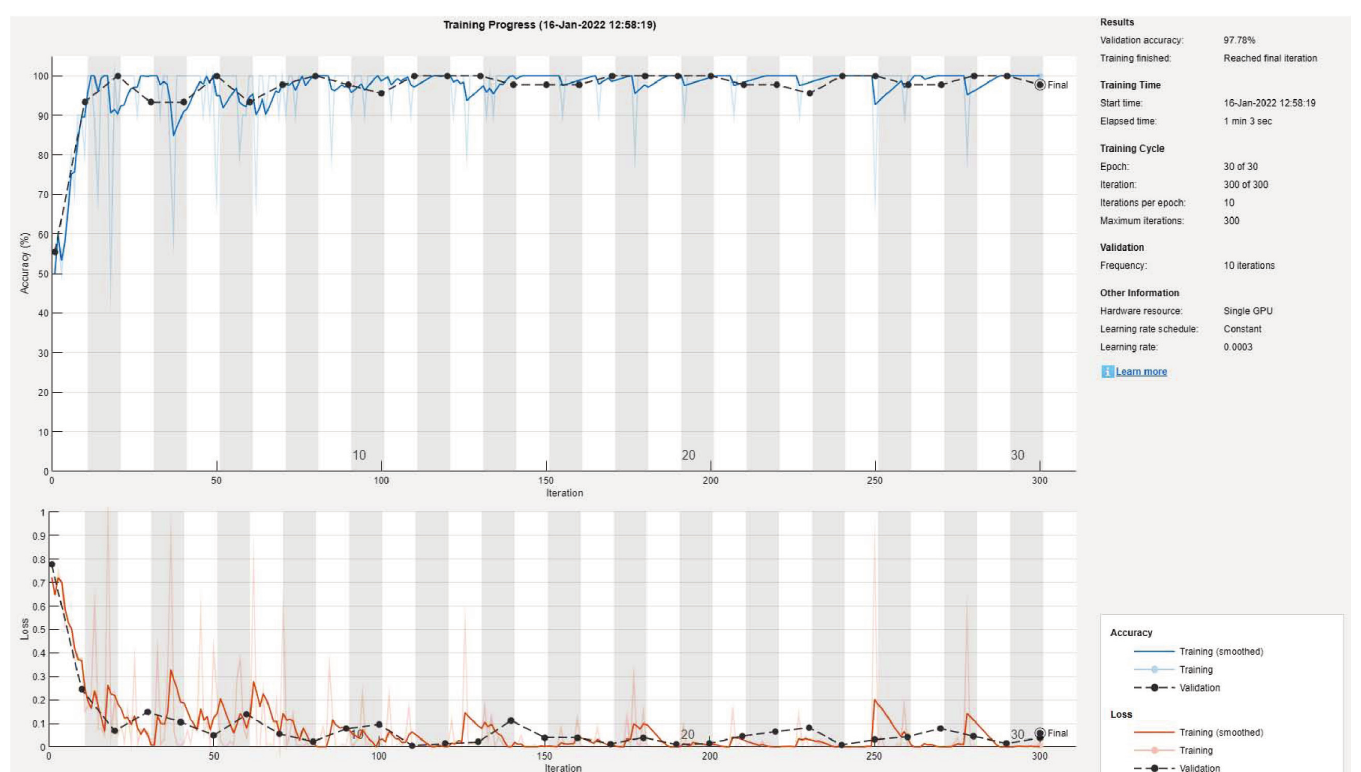
Fig 7. The RestNet-101 sample training and validation curve for normal vs spondylolisthesis